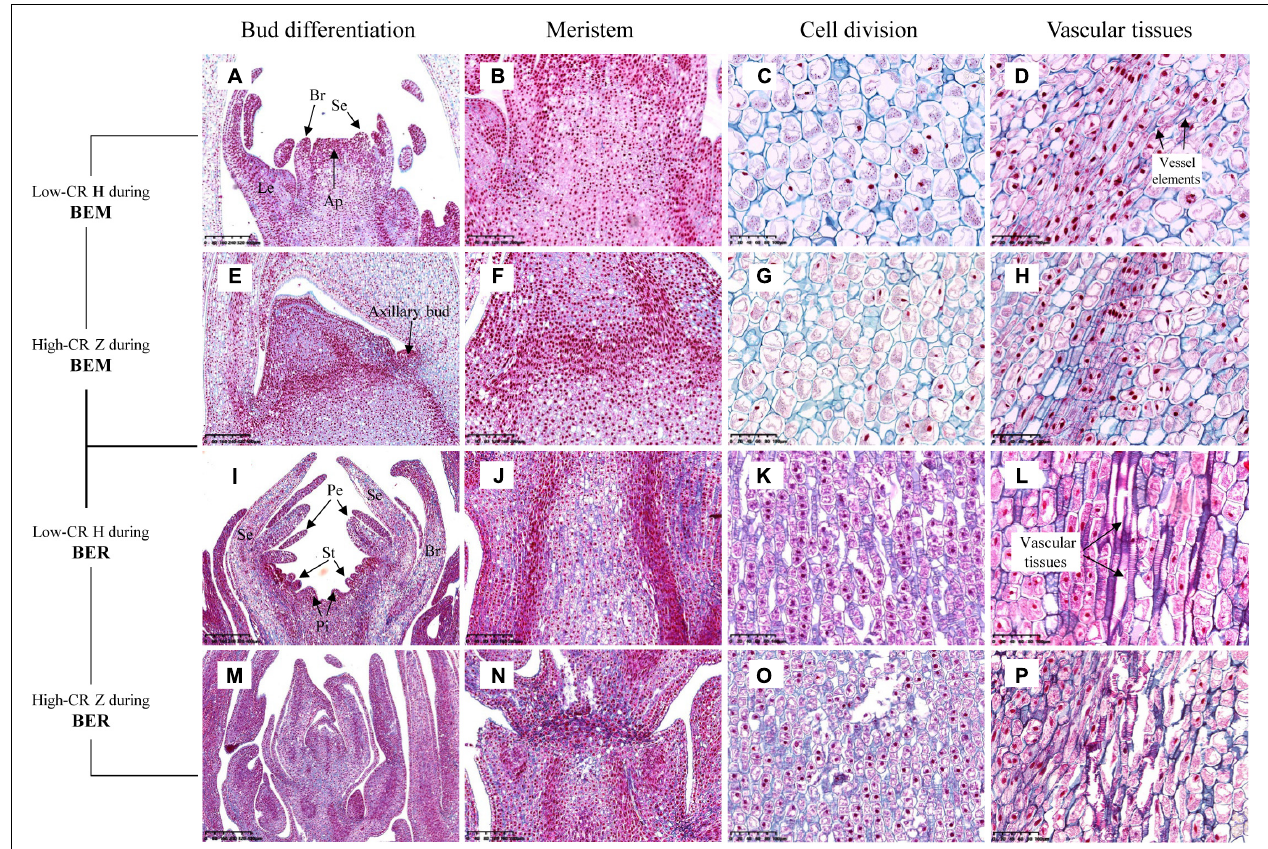
FIGURE 8 | Histocytological observations of underground buds in the two cultivars during bud endodormancy release maintenance and release stages. (A,E,I,M) Differentiation of buds (scale bar: 400 µ m). (B,F,J,N) Meristem inside the buds (scale bar: 200 µ m). (C,G,K,O) Cell division (scale bar: 100 µ m). (D,H,L,P) Vascular tissues (scale bar: 100 µ m). H represents ‘Hang Baishao’; Z represents ‘Zhuguang.’ BEM, bud endodormancy maintenance; BER, bud endodormancy